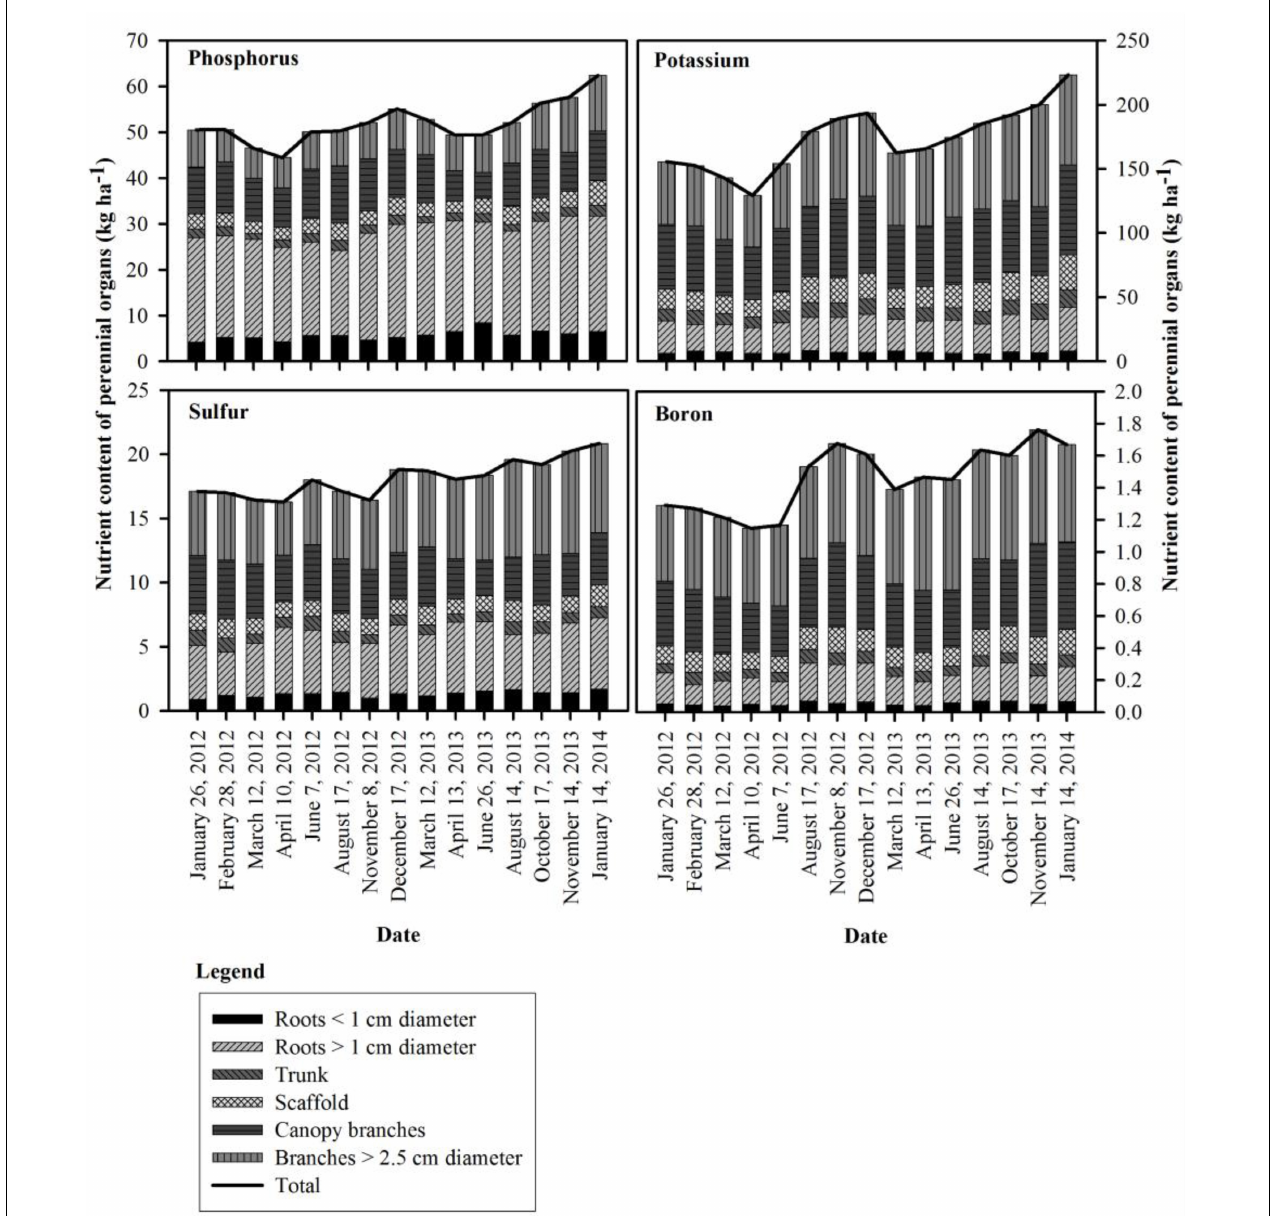
FIGURE 2 | Seasonal changes in phosphorus, potassium, sulfur and boron content of the perennial organs for the 309 kg ha − 1 N application rate in 2012 and